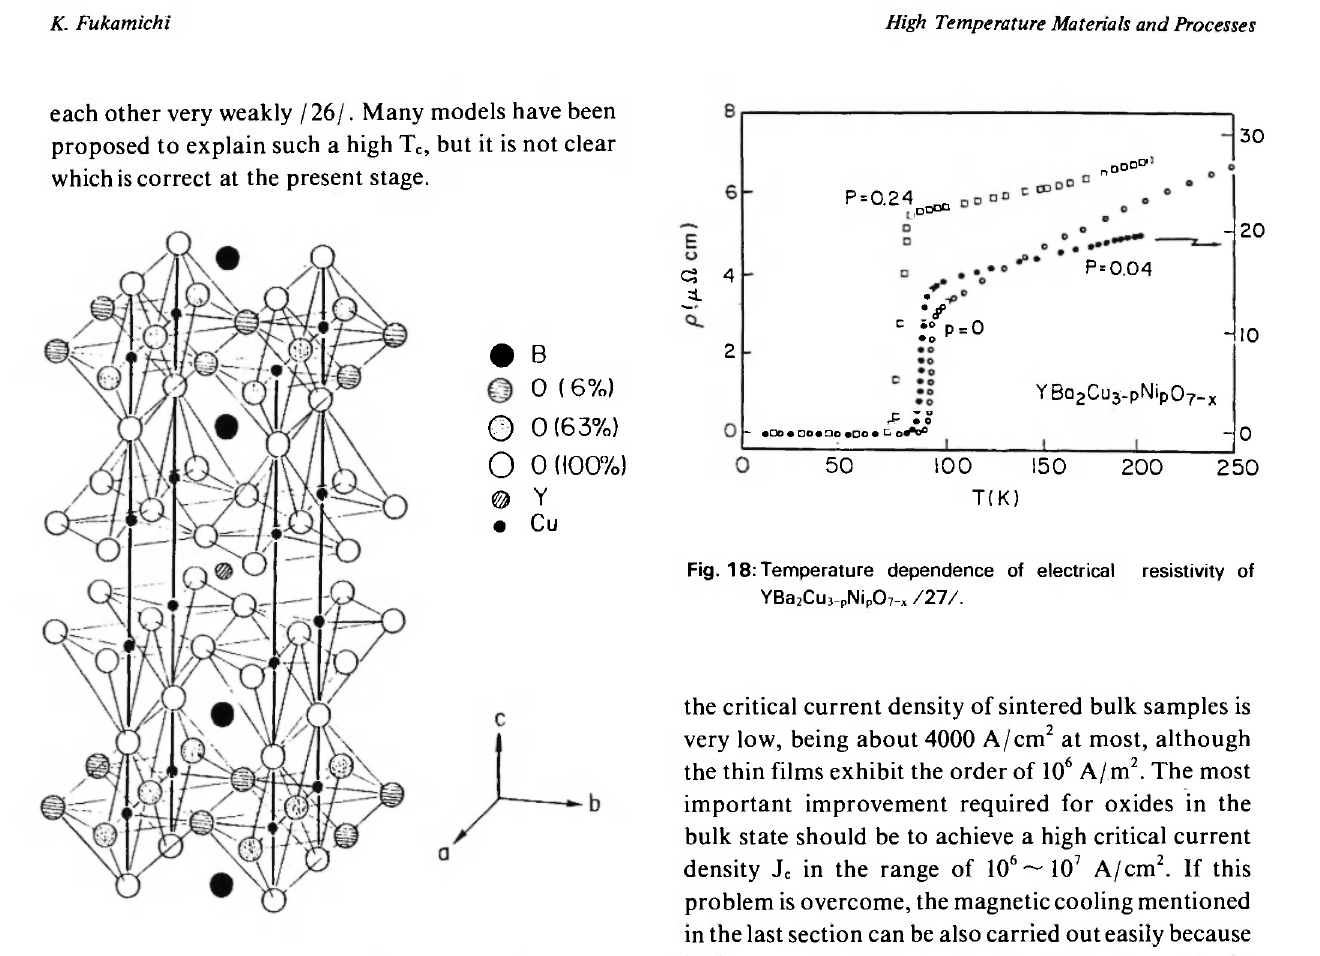
Fig. 16: Crystal structure of Y-Ba-Cu-0 orthorhombic phase I2bl.